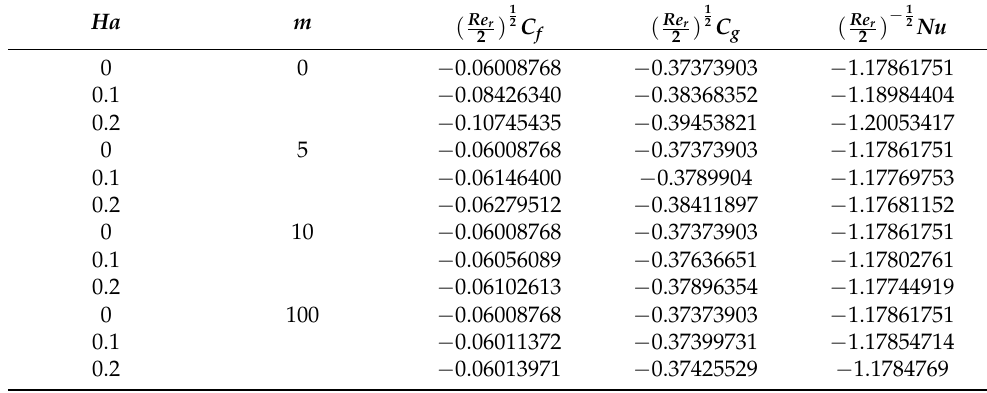
Table 4. The values of ( Re r setting R = 0.5, α = β = 0.2, δ = ζ = 0.5, Γ = 0.1, Qt = Qe = 0.2, Pr = 6, and n =